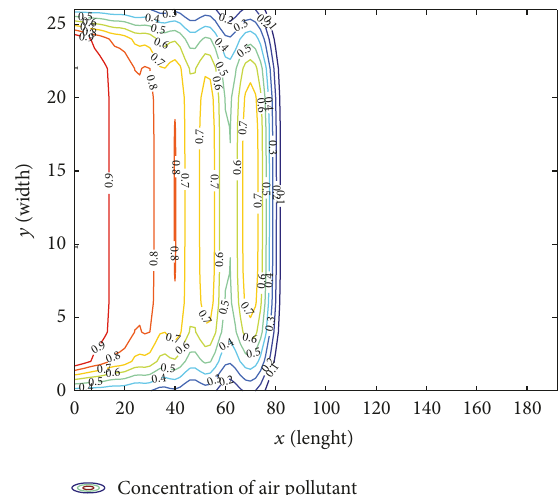
Figure 6: Contour plot of concentration of air pollutant levels for 𝑅 = 0.007 sec −1 .